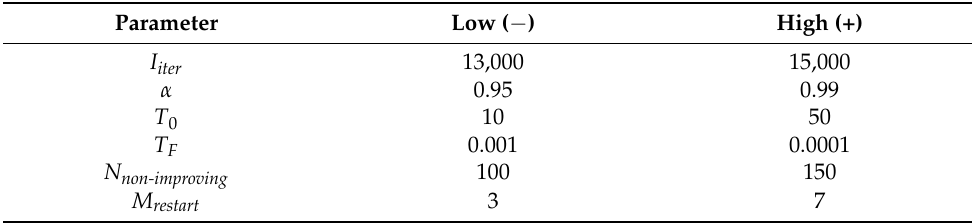
Table 2. Parameters for the 2 k factorial design of the experiment.